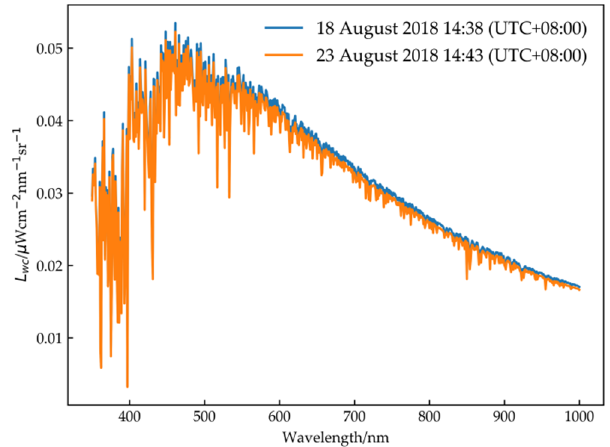
Figure 8. Whitecap Figure 8. Whitecap radiance.